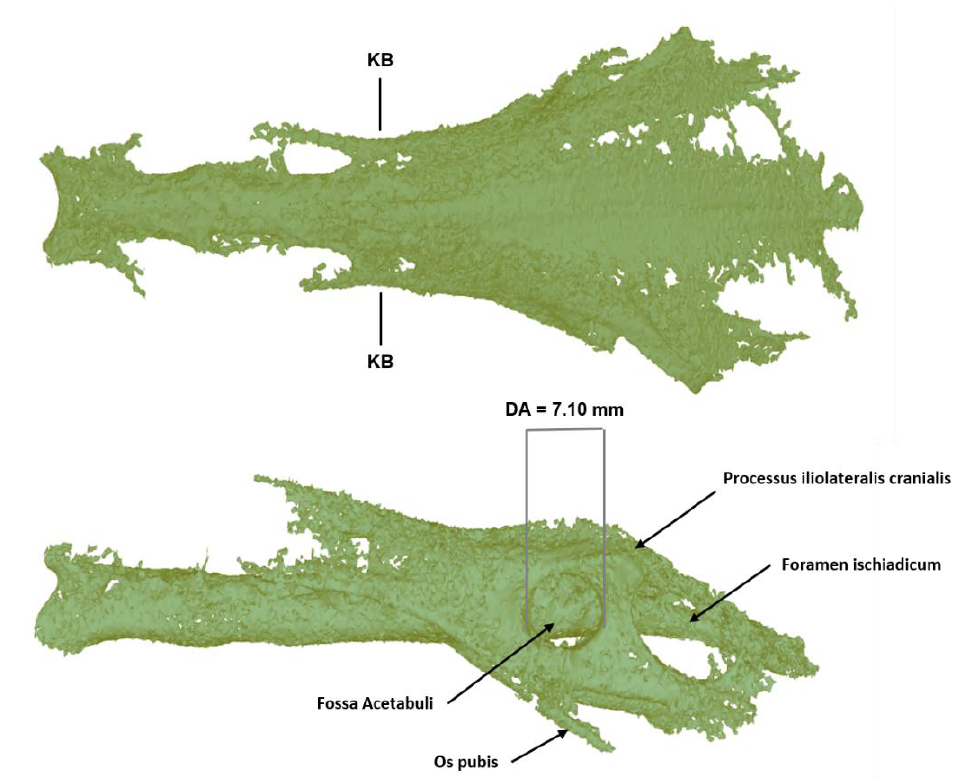
Figure 8. Three-dimensional reconstruction of the pelvis of the Ardea purpurea glacier mummy. KB: smallest width of the partes glutaeae = 12.45 mm; DA: diameter of the acetabulum (greatest distance) = 7.10 mm.